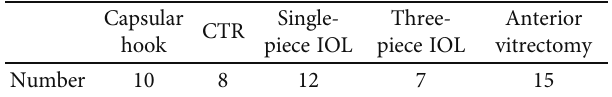
Table 2: Number of cases using capsule hook, CTR, single-piece IOL, and three-piece IOL.